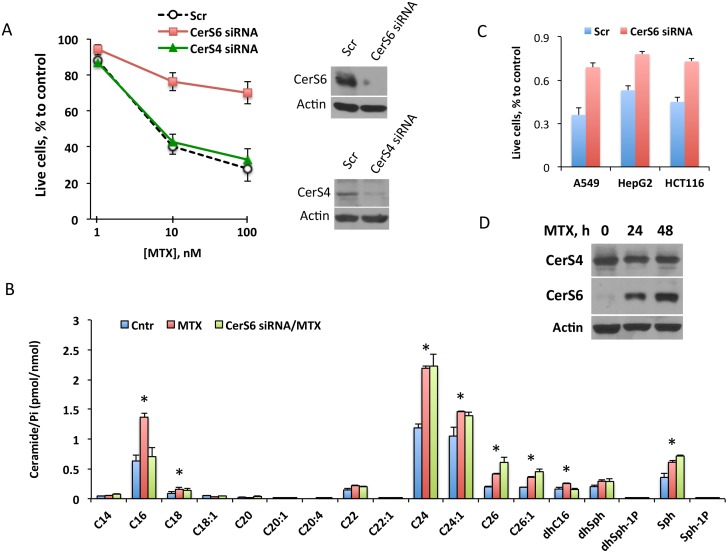
CerS6 is a target of MTX in mediation of antiproliferative effect.(A) Silencing CerS6 by siRNA rescues A549 cells from cytotoxic effect of MTX while silencing CerS4 does not change the drug toxicity. Cells were transfected with scrambled siRNA, CerS6 siRNA or CerS4 siRNA (25 pmol), MTX was added 6 h later and live cells were assessed by MTT assay 48 h after the beginning of MTX treatment. Data represent an average of two independent experiments, each performed in quadruplicates with error bars representing SD. Student’s t test was performed for statistical analysis (difference in cell number between control and CerS6-silenced cells were statistically significant with p<0.005; there were no significant differences in cell number between control and CerS4-silenced cells). Panels on the right show the efficiency of CerS6 and CerS4 silencing (evaluated at 48 h of MTX treatment). (B) Levels of ceramide in control A549 cells (Cntr, transfected with scrambled siRNA), MTX-treated cells transfected with scrambled siRNA (MTX) and MTX-treated cells after CerS6 silencing (CerS6 siRNA/MTX, transfected with CerS6 siRNA). Differences between the groups were analyzed by one-way ANOVA and asterisks indicate statistically significant changes (p<0.05). (C) Silencing of CerS6 by siRNA protects cancer cells from MTX cytotoxic effect. Student’s t-test was performed and the differences between MTX effect in control and CerS6-silenced cells were statistically significant (p<0.01). (D) MTX (10 nM) leads to elevation of CerS6 but not of CerS4 in A549 cells.